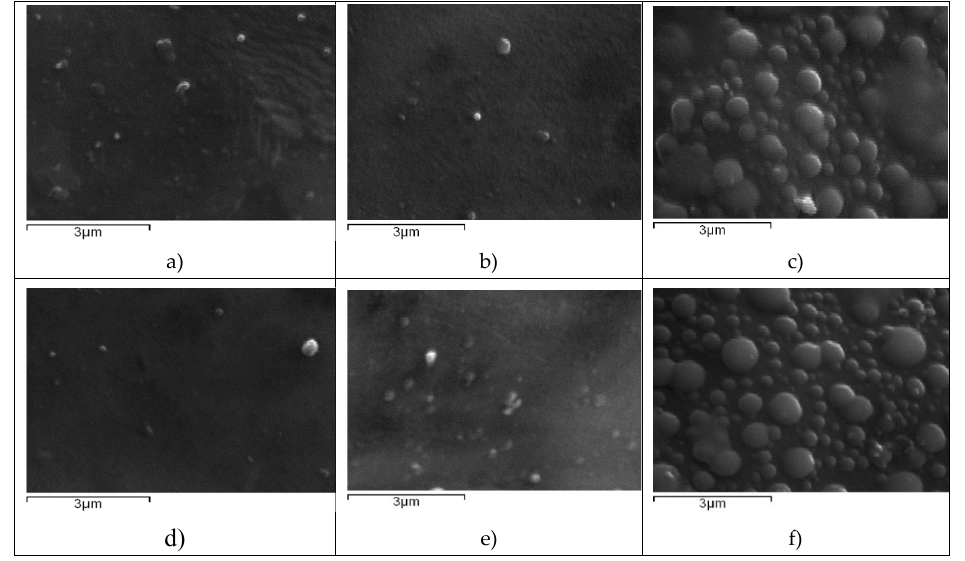
Figure 3. SEM image of: ( a ) CS-TPP-BUD 10%, ( b ) CS-TPP-BUD 20%, ( c ) CS-TPP-BUD 30%, ( d ) CS-TPP-PVA-BUD 10%, ( e ) CS-TPP-PVA-BUD 20% and ( f ) CS-TPP-PVA-BUD 30%.